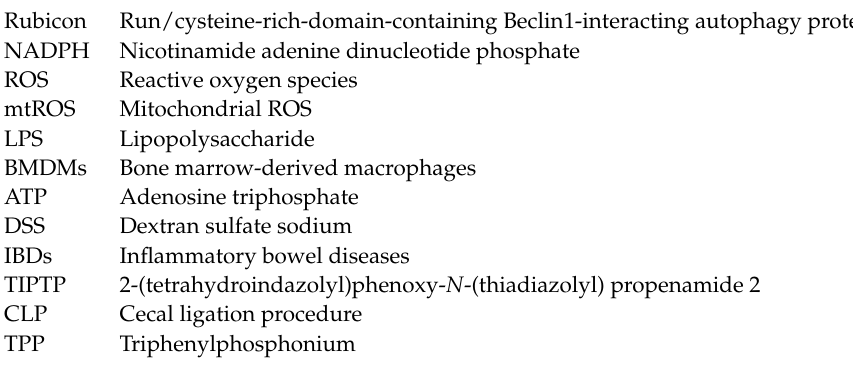
Figure S6: Full-length images of the blots; Table S1: Experimental procedures for the synthesis of Mito-TIPTP